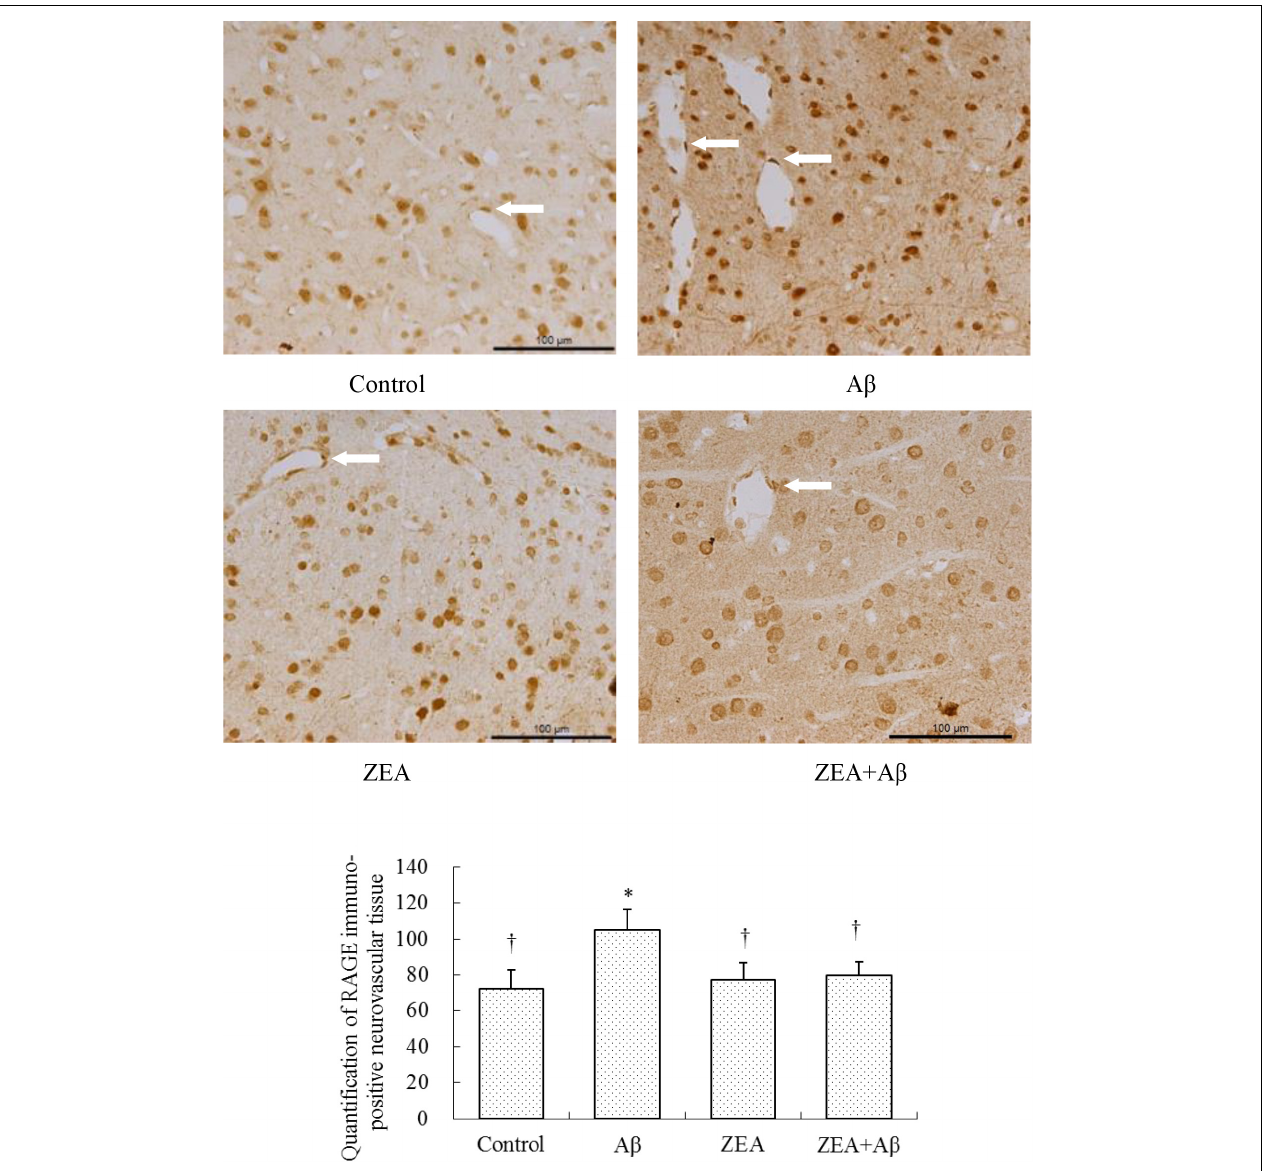
FIGURE 7 | Neuroprotective effects of ZEA on RAGE in the cerebrovascular tissue of learning and memory impairment rats induced by A β 1–42. Immunohistochemistry was used in the paraffin section of the whole rat brain from four treatment groups mentioned before ( n = 12 per group). All the data were shown as mean ± SD, and analyzed by the one-way ANOVA test [ post hoc (LSD) test]. ∗ Significantly different from the Control group ( p < 0.05). † Significantly different from the A β group ( p < 0.05). Staff gauge showed 100 µ m at the right side of every pictures’